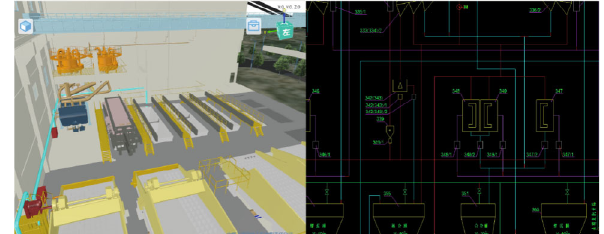
Figure 9: Linkage between PID diagram and CAD model of Wangjialing Coal Preparation